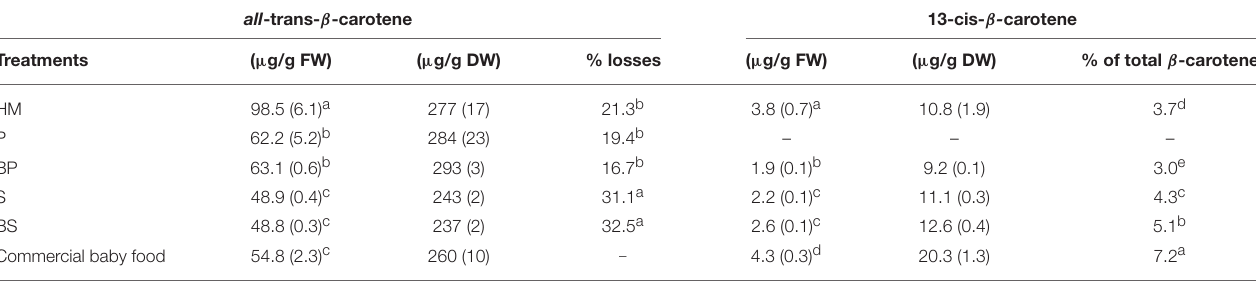
TABLE 1 | Carotenoids contents in OFSP puree and retention after thermal treatments. all -trans- β -carotene 13-cis- β - carotene